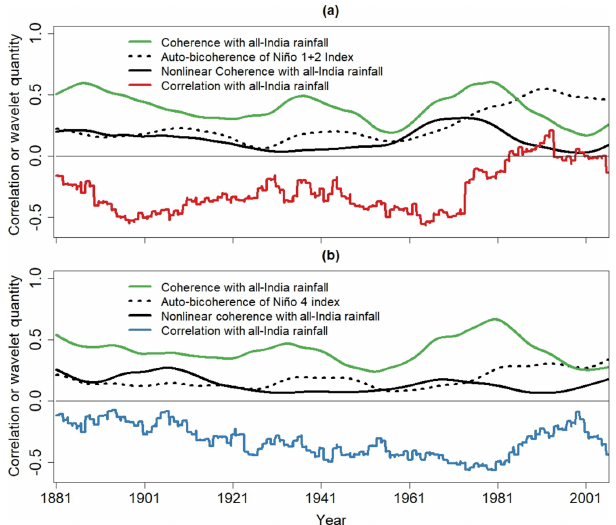
Figure 10. (a) The 20-year sliding mean time series of the linear wavelet coherence between AIR and the Niño 1 and 2 index, the auto-bicoherence of the Niño 1 and 2 index, and the nonlinear co- herence between the Niño 1 and 2 index and AIR after they have been averaged in the band of 16 to 64 months. The red curve is the 20-year sliding correlation between the August–September Niño 1 and 2 index and AIR. (b) The same as (a) but for the Niño 4 in- dex. The blue curve is the 20-year sliding correlation between the August–September Niño 4 index and AIR.